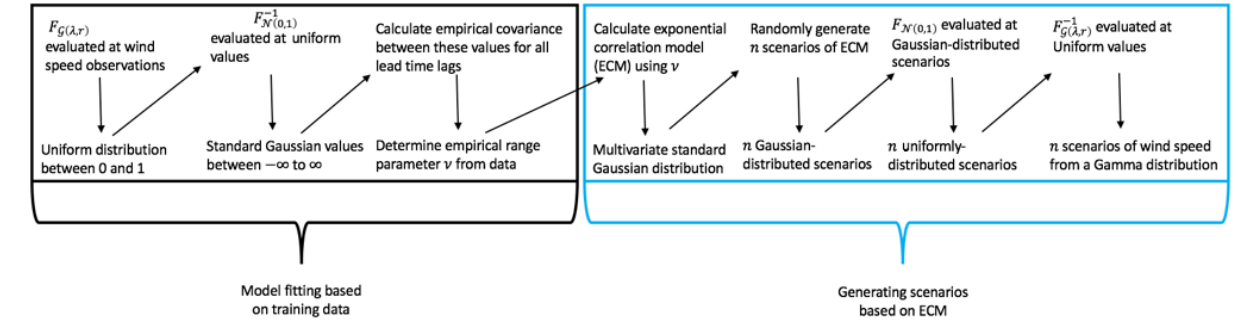
Figure 5. Flow diagram of how the Gaussian copula method is used to generate n number of wind speed scenarios from a multivariate Gamma distribution. Downward-pointing arrows show the result of the top processes. The diagonally pointing arrows illustrate the next step in the method. The original wind speeds do not have to be transformed, but for this study, we begin this method using transformed wind speeds from a univariate Gamma distribution, which results in n number of scenarios of transformed wind speeds from a multivariate Gamma